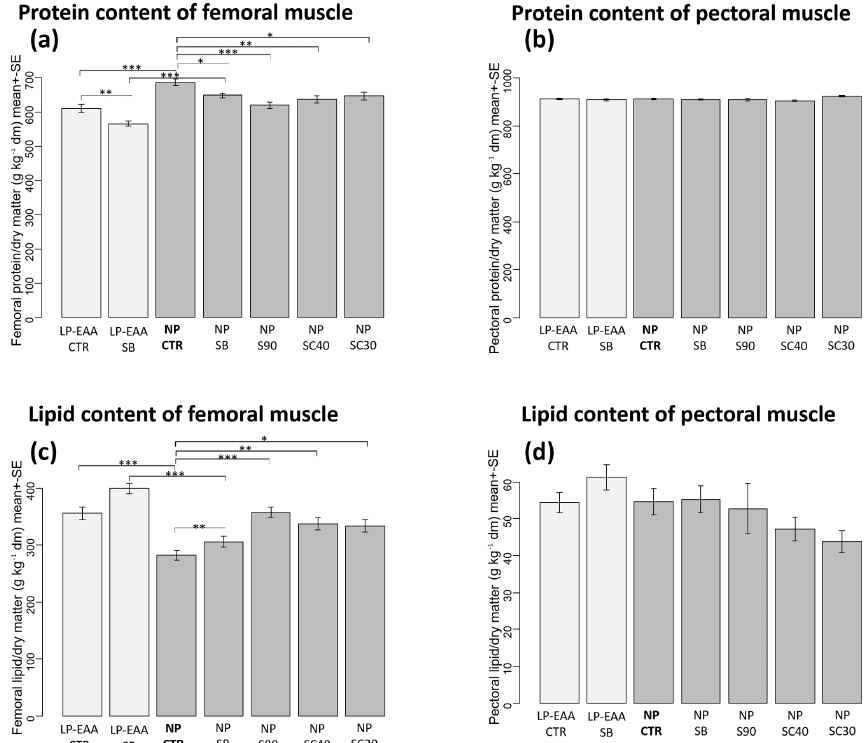
Figure 2. Results of chemical analysis of muscle composition. (a) Protein content of the femoral muscle. (b) Protein content of pectoral muscle. (c) Lipid content of the femoral muscle. (d) Lipid content of pectoral muscle. The abbreviations of the experimental groups are indicated in Table 1. Results are expressed as mean ± SE in grams per kilograms of dry matter (dm). Significant differences revealed by post hoc tests are marked in the following way: ∗ P < 0 . 05; ∗∗ P < 0 . 01; ∗∗∗ P < 0 . 001.